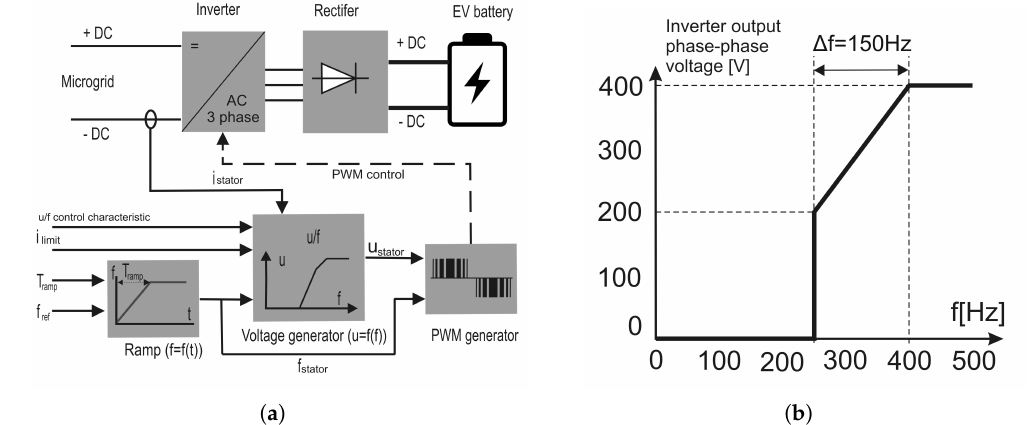
Figure 7. Drive VFC implemented as an electric vehicle (EV) fast charger: ( a ) control of industrial Pulse Width Modulation (PWM) drive converter with output rectifier, ( b ) special characteristic of inverter phase-phase